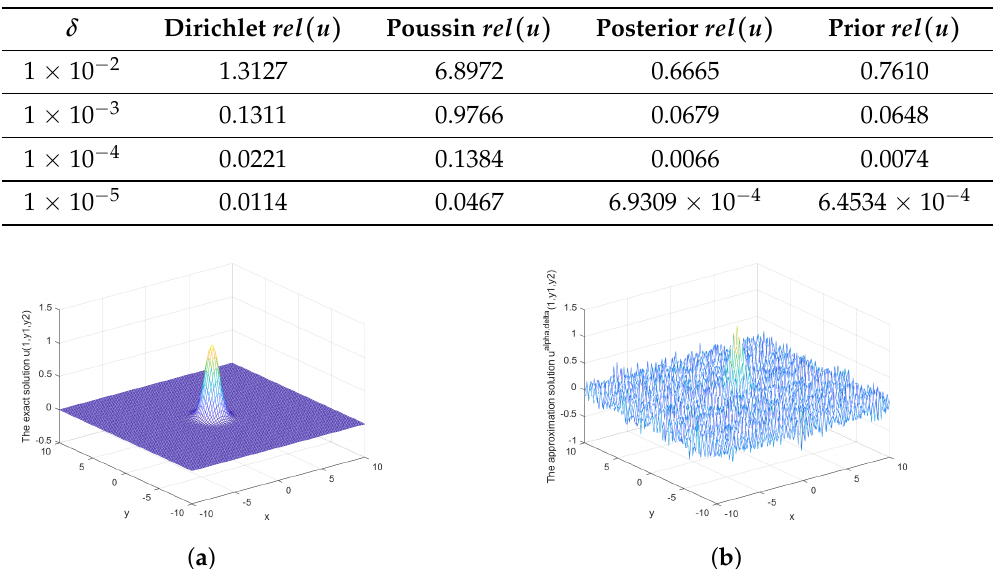
Table 1. Comparison between different regular solutions at x = 0.2.